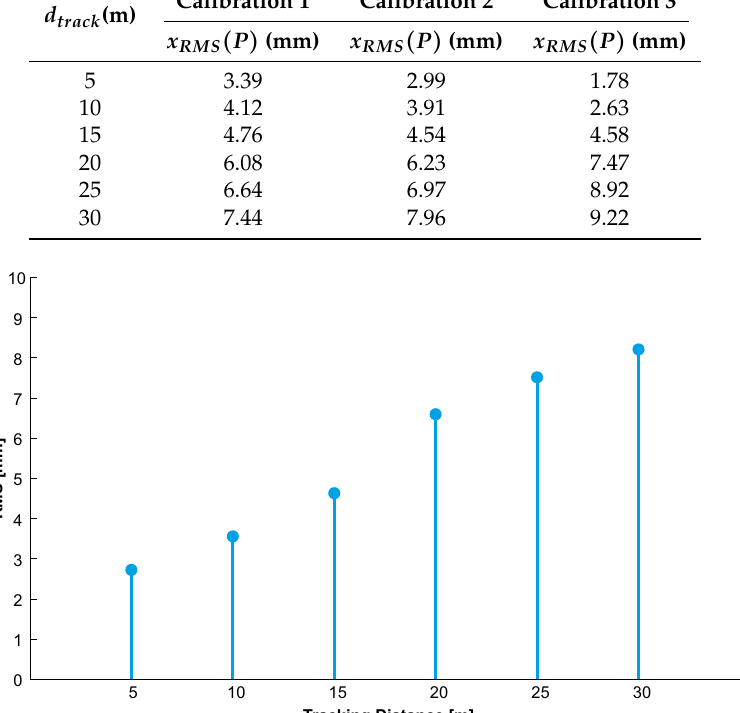
Figure 21. Mean of relative accuracy x RMS ( P ) over all three